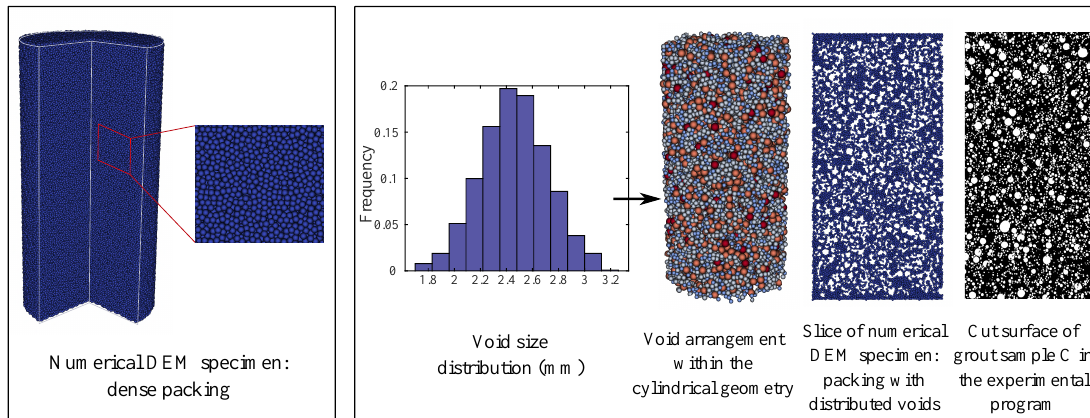
Figure 8. ( Left ): Numerical model of an initial sample A with a dense packing constituting the basis for the generation of DEM models B and C with air voids. ( Right ): Generation of numerical DEM model for samples with distributed voids and comparison with a photo from the cut surface of sample C.